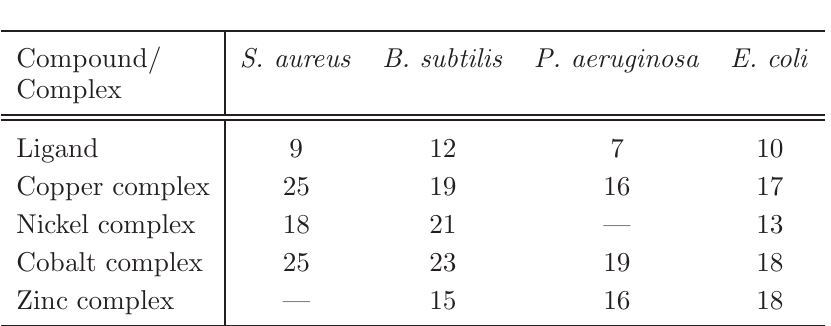
Table 4 Antibacterial activity of the synthesized compounds at 10 − 2 M (zone of inhibition in